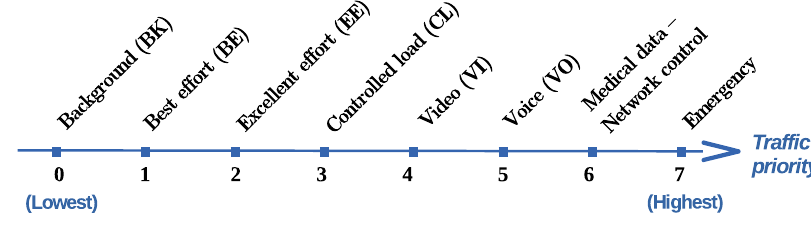
Figure 4. WBAN traffic priorities according to